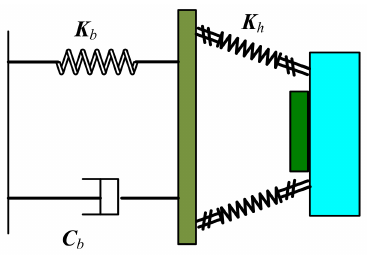
Figure 5. Equivalent